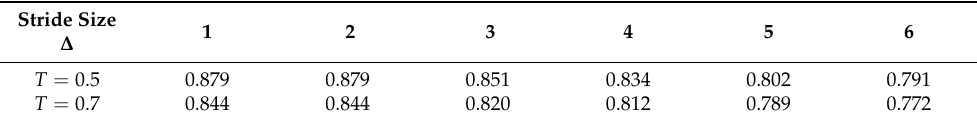
Table 6. The average EDA performance of the proposed algorithm for various stride sizes for inference. The ITR ratio for the proposed algorithm was r = 0.3.